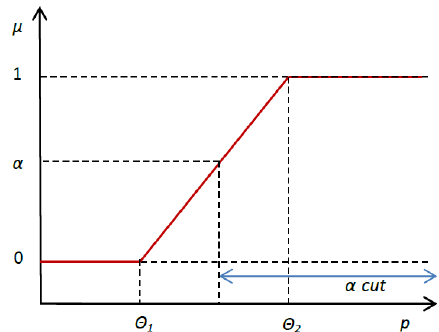
Figure 2. Concept for a fuzzy set of acceptable outcomes A µ over performance R